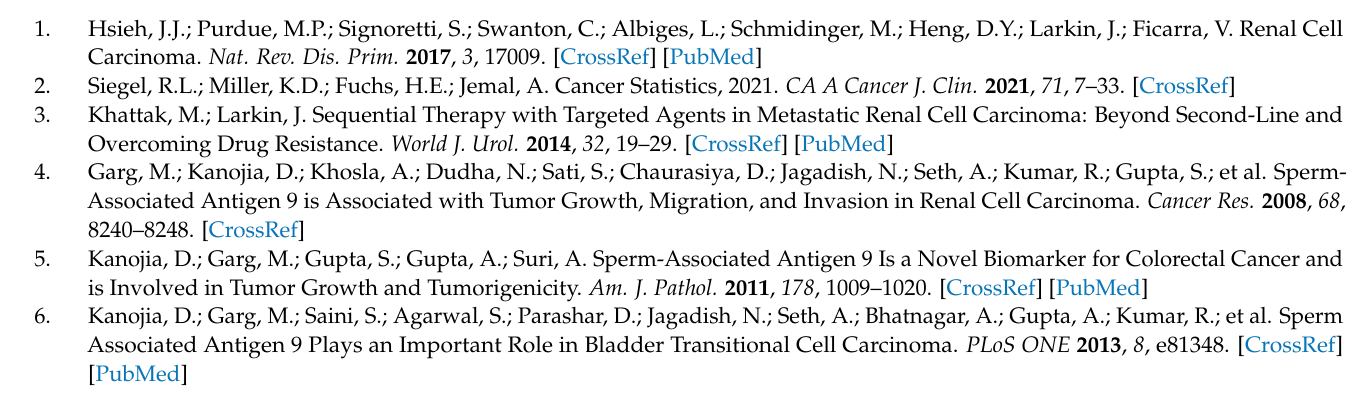
Table S3: Primers designed for this study. Table S4: The qPCR data after analysis with 2 − ∆∆ Ct method. Table S5: The role of SPAG9 in different tumor-cell lines; Table S6: The correlation between the activity scores of pathways and OS in ccRCC. Table S7: Workflow for screening of key